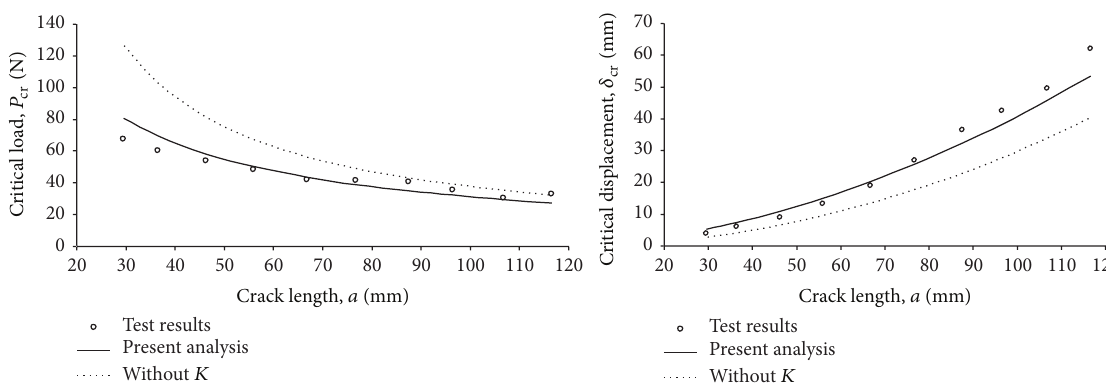
) and the corresponding dis- cr